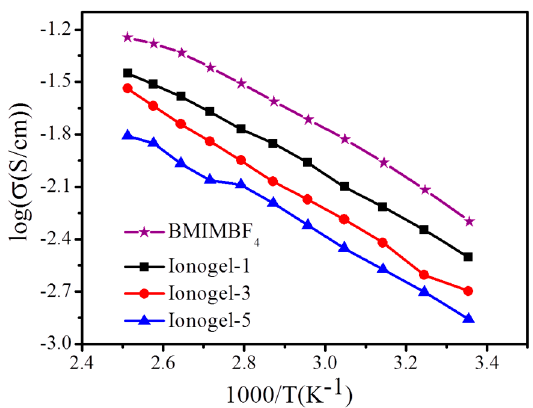
Figure 6. Temperature dependence of ionic conductivities for neat BMIMBF 4 and ionogel shown in the Arrhenius